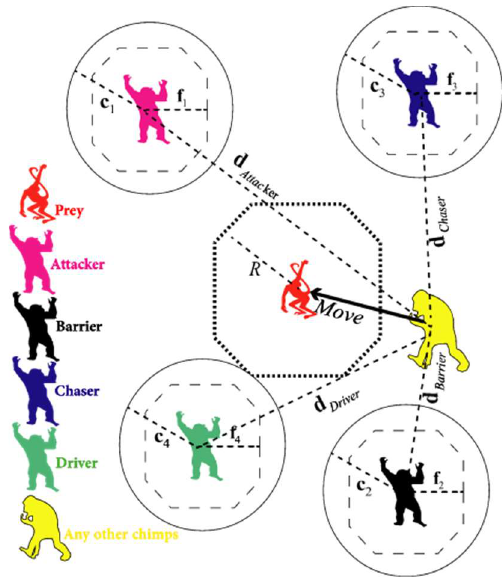
Figure 5. Position updating in ChOA.